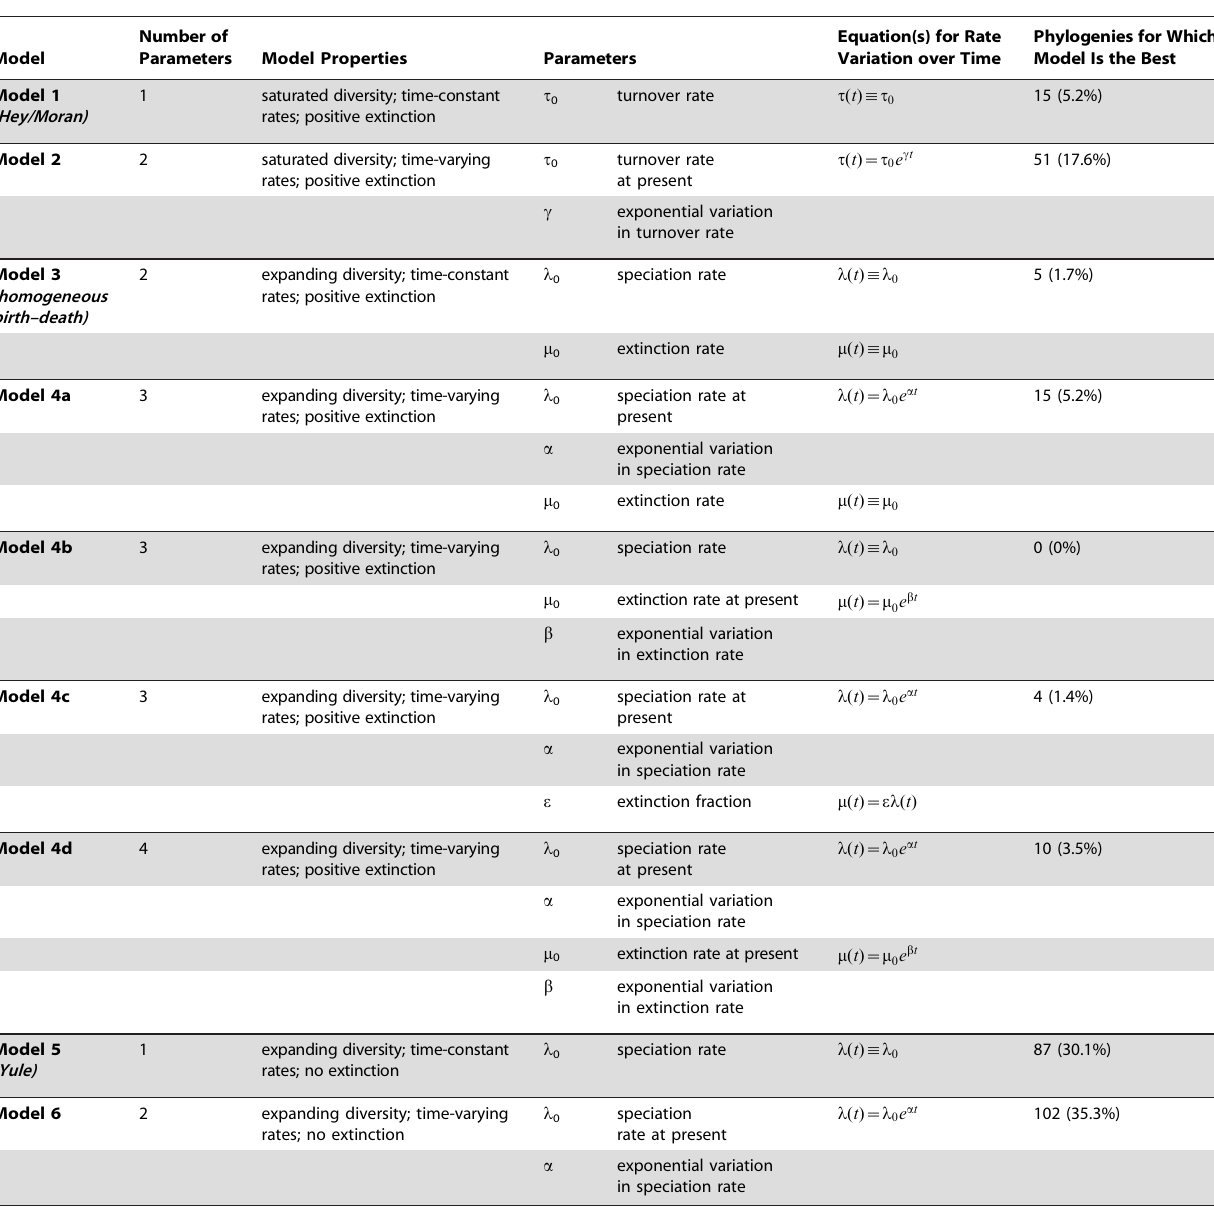
Table 1. Nine diversification models, their parameters, and empirical support.